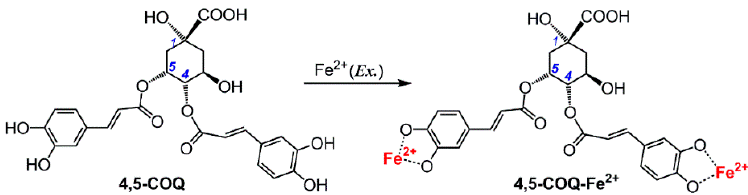
Figure 3. The proposed chelating reaction of 4 , 5-COQ (4,5-di- O- caffeoylquinic acid) with excessive Fe 2+ (the reaction formula is proposed based on previous studies [11,22–24]).